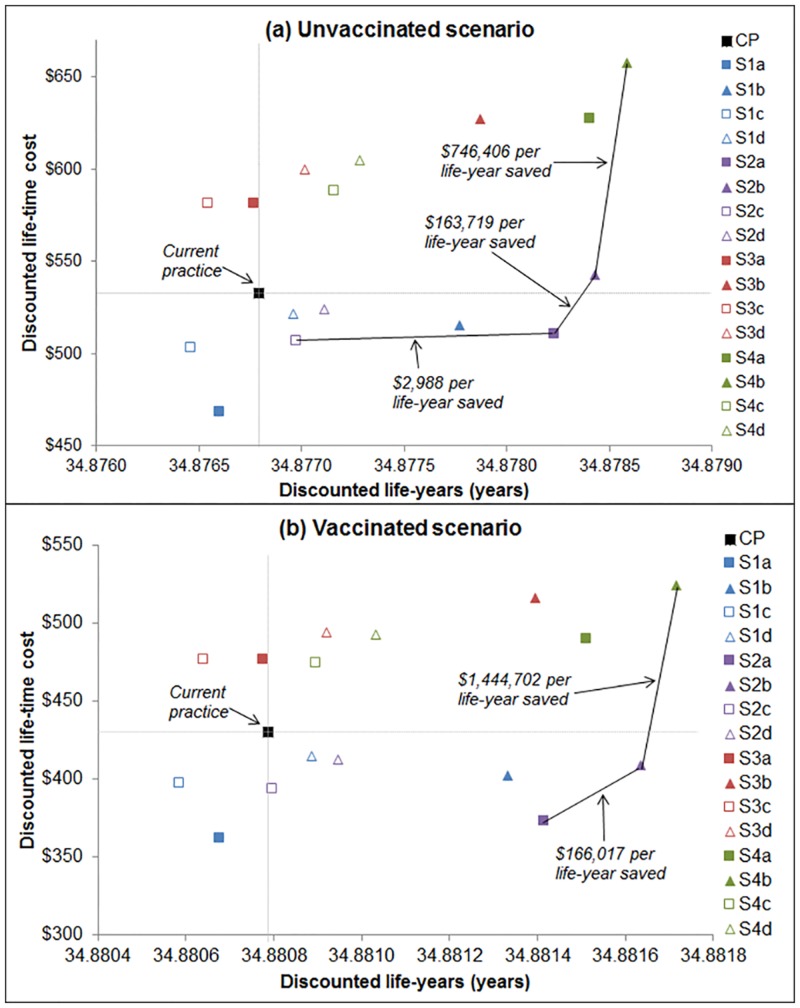
Cost-effectiveness planes for (a) unvaccinated scenario and (b) vaccinated scenario.